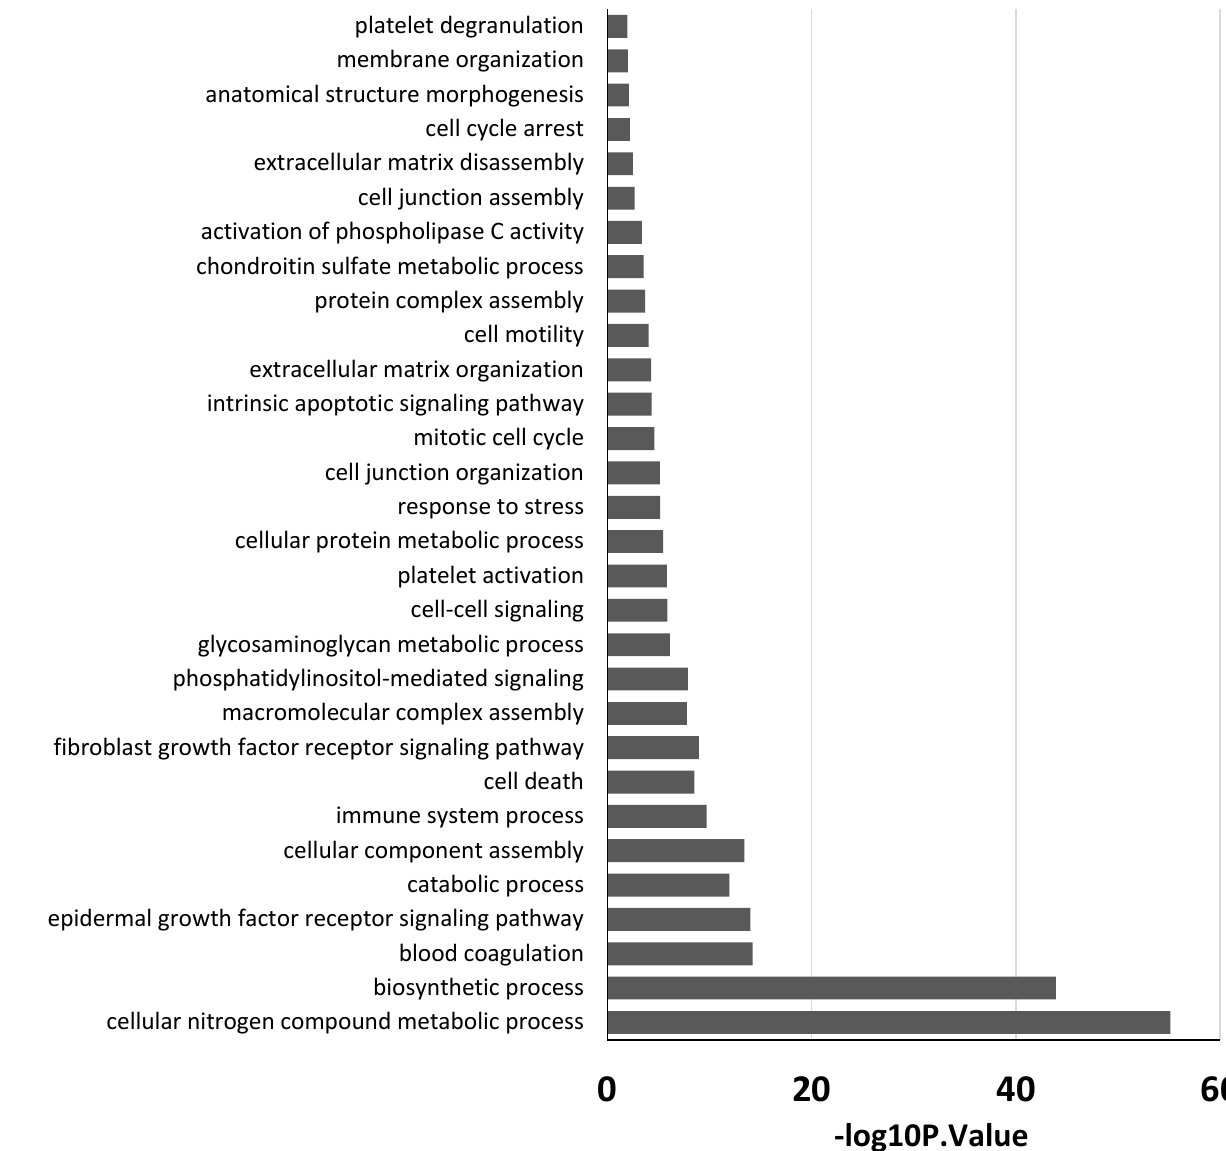
Figure 3. GO analysis of eleven miRNAs deregulated in group B patients. Partial list of biological process enrichment analysis.